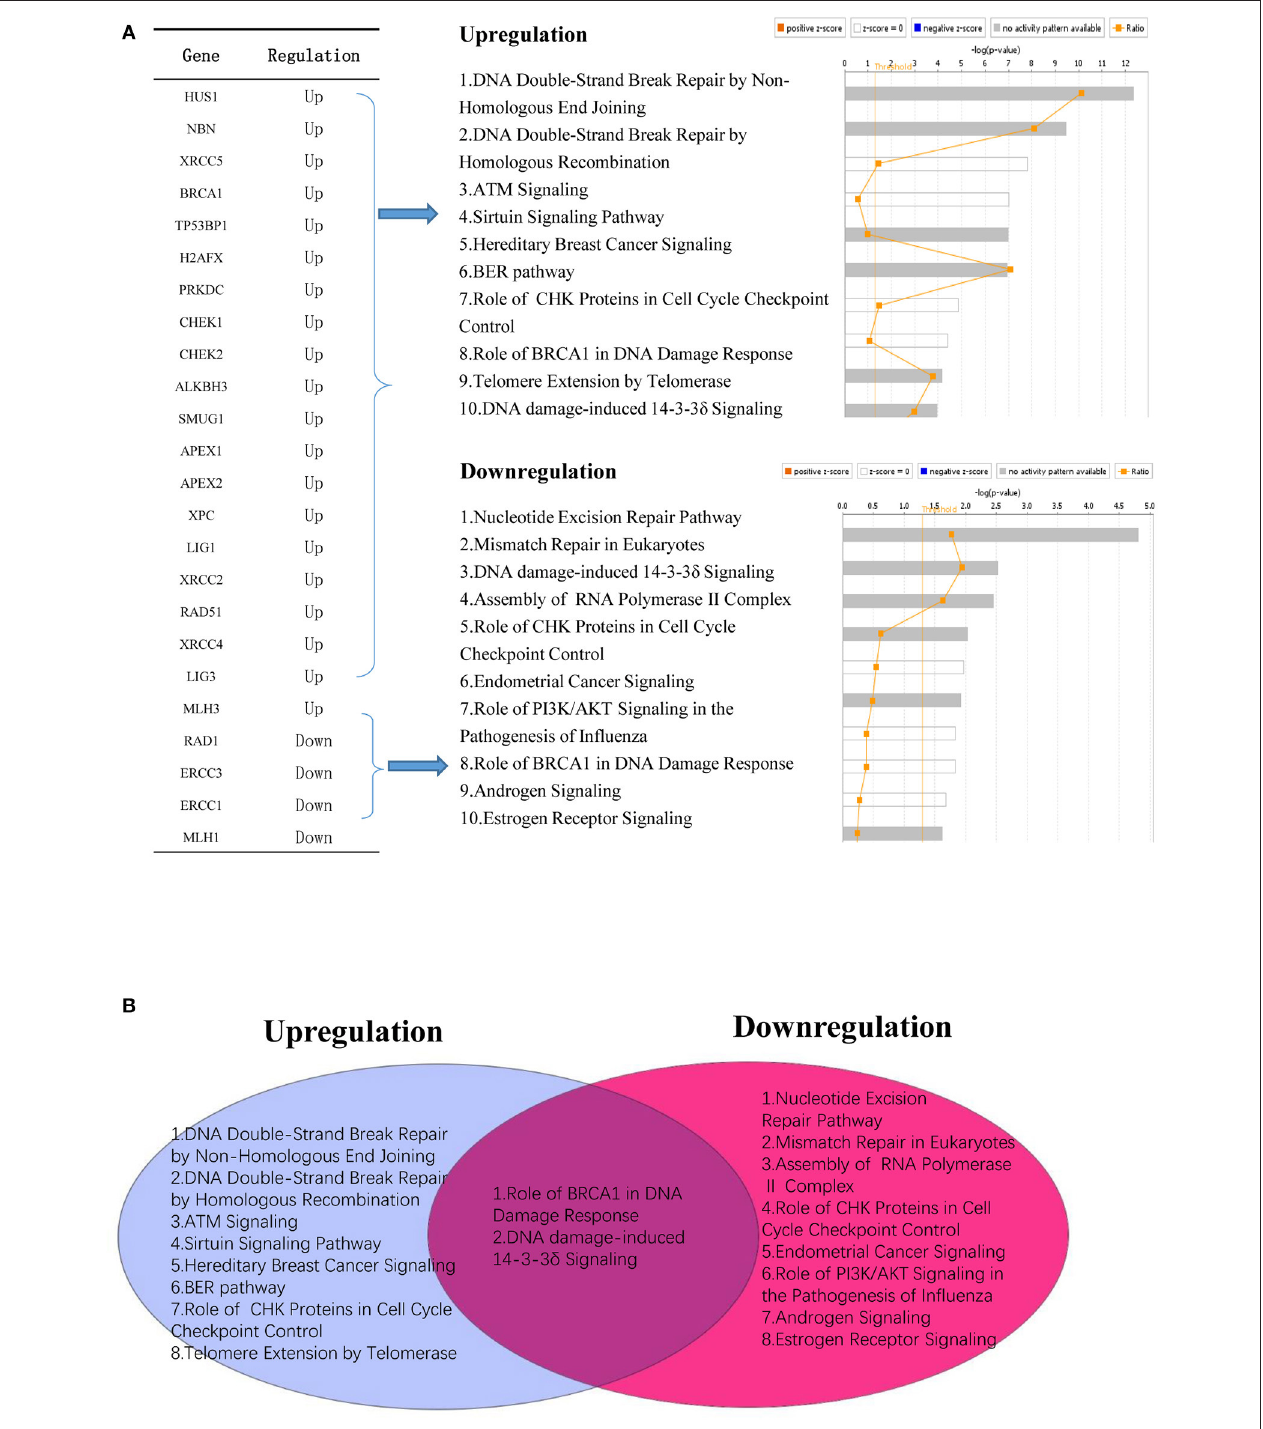
FIGURE 7 | Modulated DNA response factors in cancer are involved in distinct cellular signaling networks. (A) Upregulated DNA damage response factors (20/68) and downregulated DNA damage response factors (4/68) modulate different signaling mechanism in human cancers. (B) Venn diagram shows that two signaling mechanisms are shared between upregulated and downregulated DNA damage response factors in human cancer.